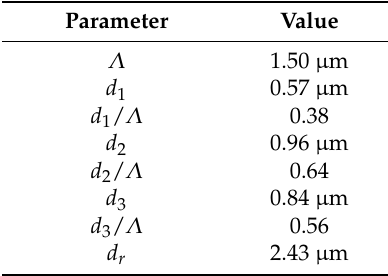
Table 3. Geometrical parameters of the dispersion-optimized PCF.